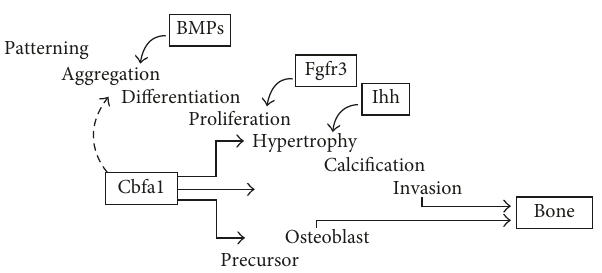
Figure 1: Role of Cbfa1 in bone formation (from